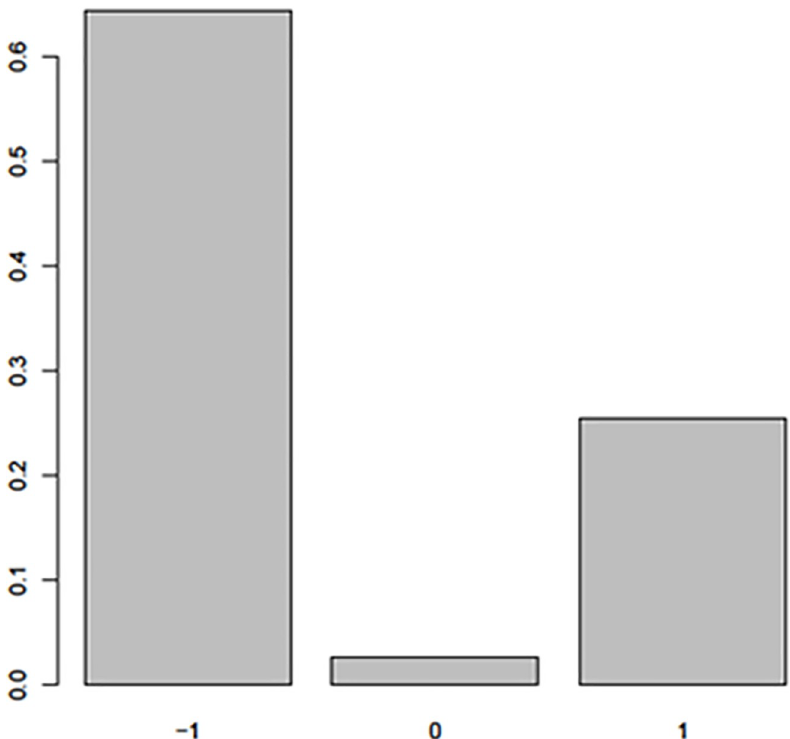
Fig 5. Genotype frequencies. Genotypes are coded as -1, 1, 0, respectively, for homozygotes for reference and alternative alleles, and